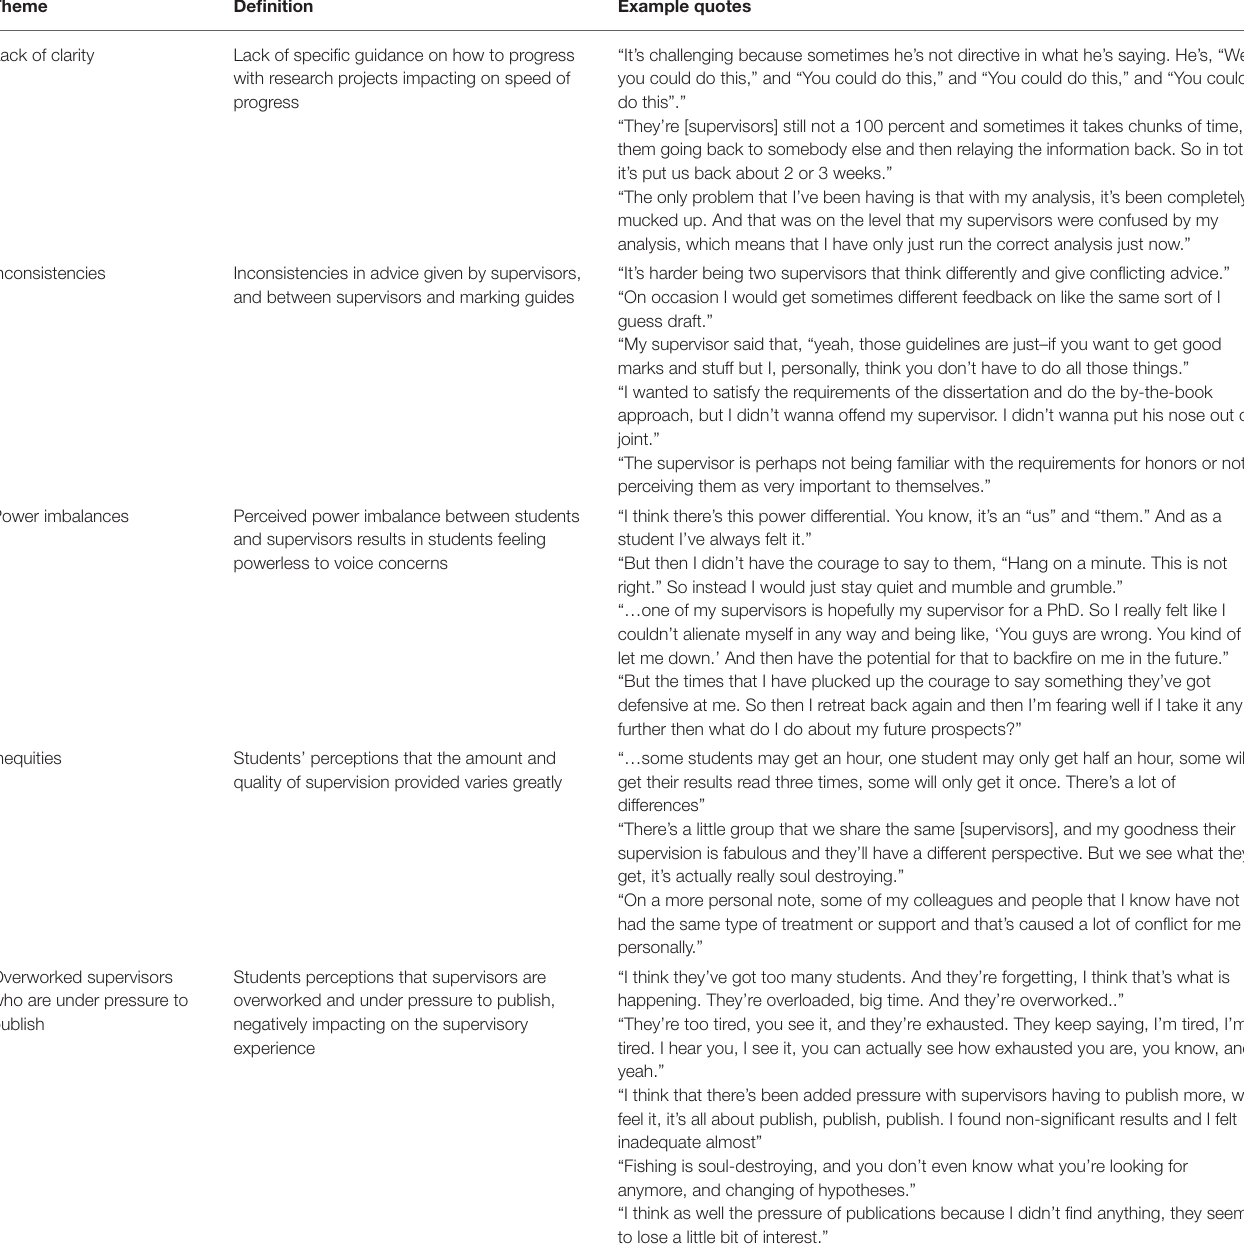
TABLE 2 | Themes relating to students’ perceptions of supervisory